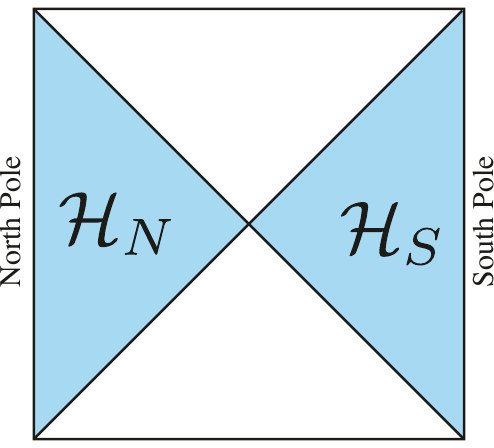
Figure 1 . Two antipodal static patch regions (shaded blue). The thermofield double state with Hilbert space H TFD = H N ⊗ H S is constructed by maximally entangling the two static patches. state one first introduces a second decoupled (antipodal) static patch region and